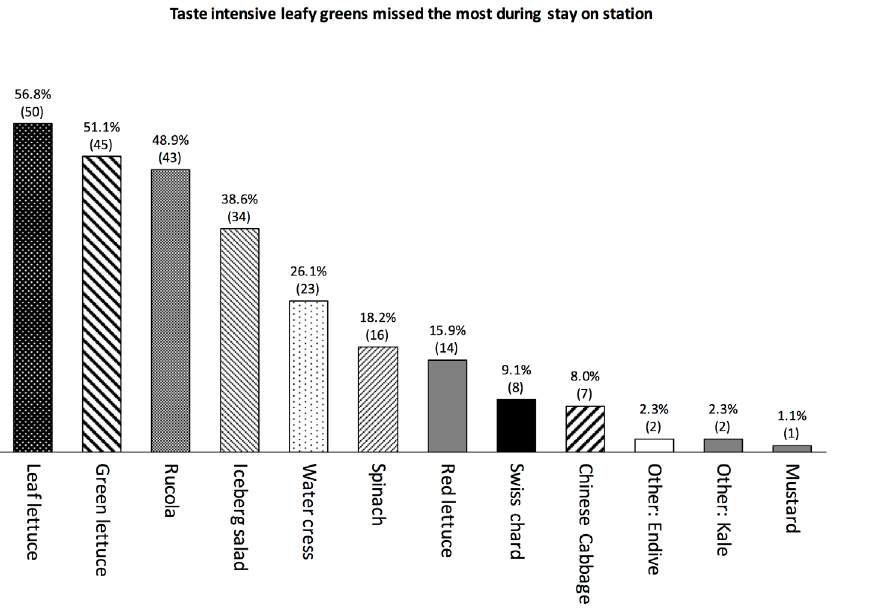
Figure 5: The 85% of respondents indicating that the availability of fresh fruit, vegetables and herbs grown on the Neumayer Station (85%, 88 individuals) would improve their overall well-being were asked to choose up to three crops from the crops listed in the category ‘Taste intensive leafy greens’ or to make their own suggestions. The presented data consists of a total of 245